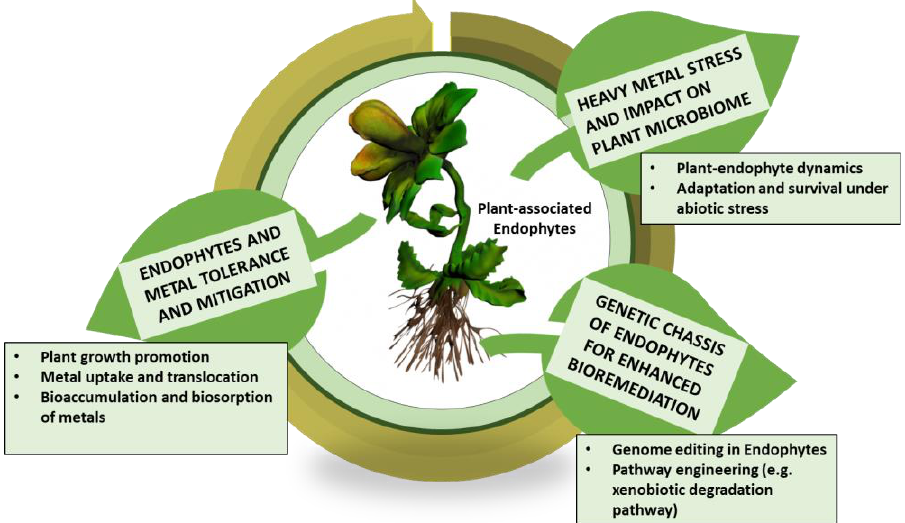
Figure 1. Recent trends in harnessing plant endophytic microbiome for HM mitigation in plants. Efforts have been made to understand and discuss the implications of HMs on plant–endophytic dynamics and the beneficial effects of endophytes on the phytoremediation of HMs and tolerance. Furthermore, the genetic chassis of endophytes (via CRISPR-Cas-based genome editing and path- way engineering) can create high-value strains with potent efficacy towards tolerance and enhanced HM alleviation from contaminated sites.